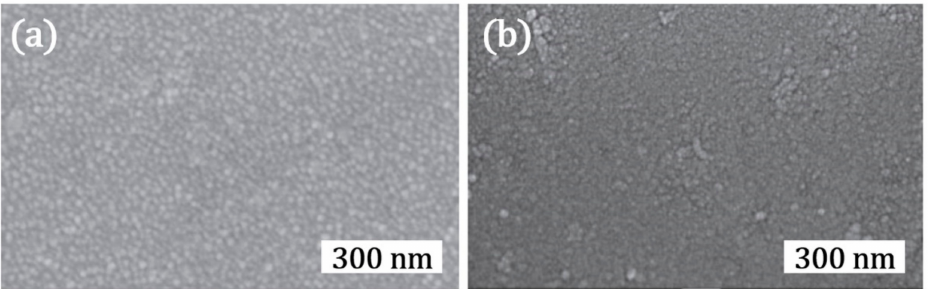
Figure 6. SEM top view micrographs of TiO 2 thin films deposited on glass ( a ) as deposited and ( b ) annealed at 200 ◦ C. Adapted with permission from [41]. Copyright (2016) IOP.